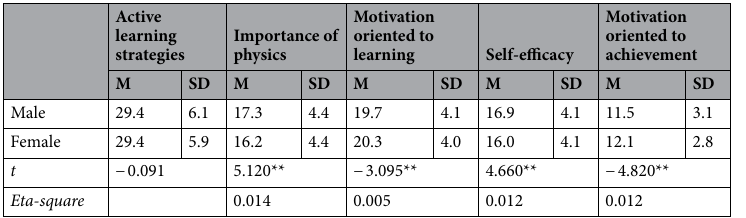
Table 1. Gender differences on observed motivational components. ** p < 0.01.